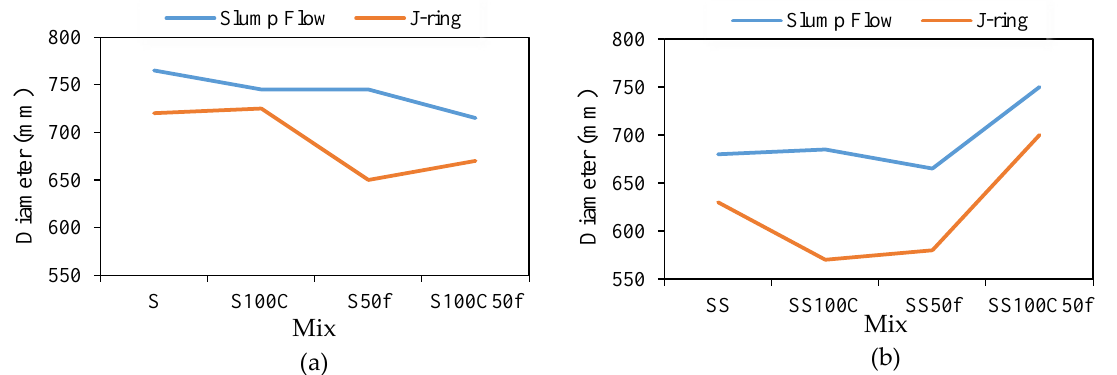
Figure 6. Slump test flow diameter and J-ring flow diameters ( a ) series I, and ( b ) concrete mixtures series II.